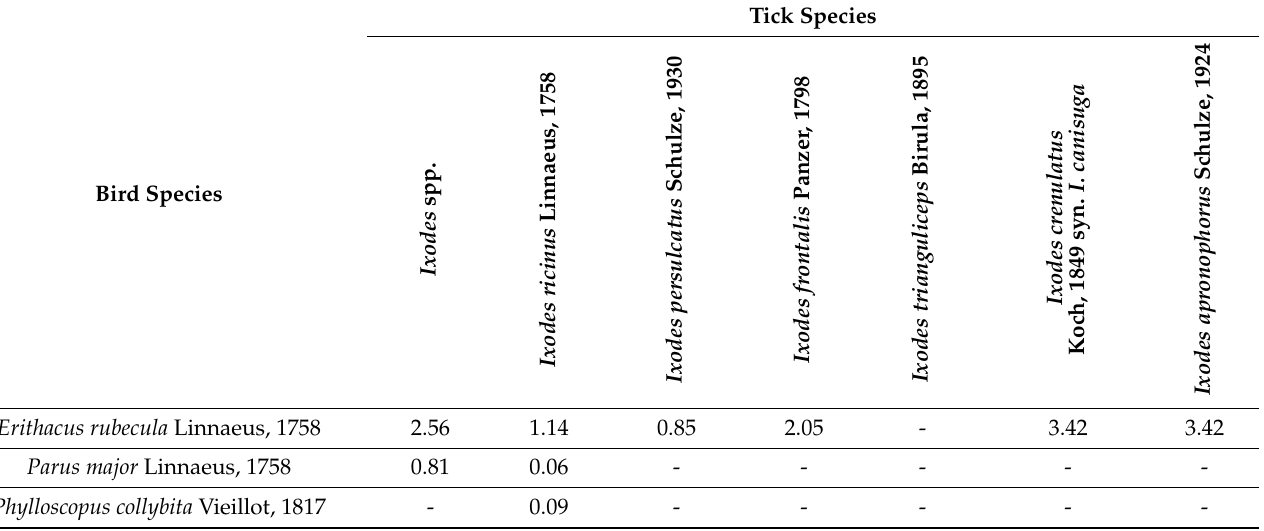
Table 4. Index of host preferences of ticks collected from the birds (only bird species with at least 100 captured individuals were included in the